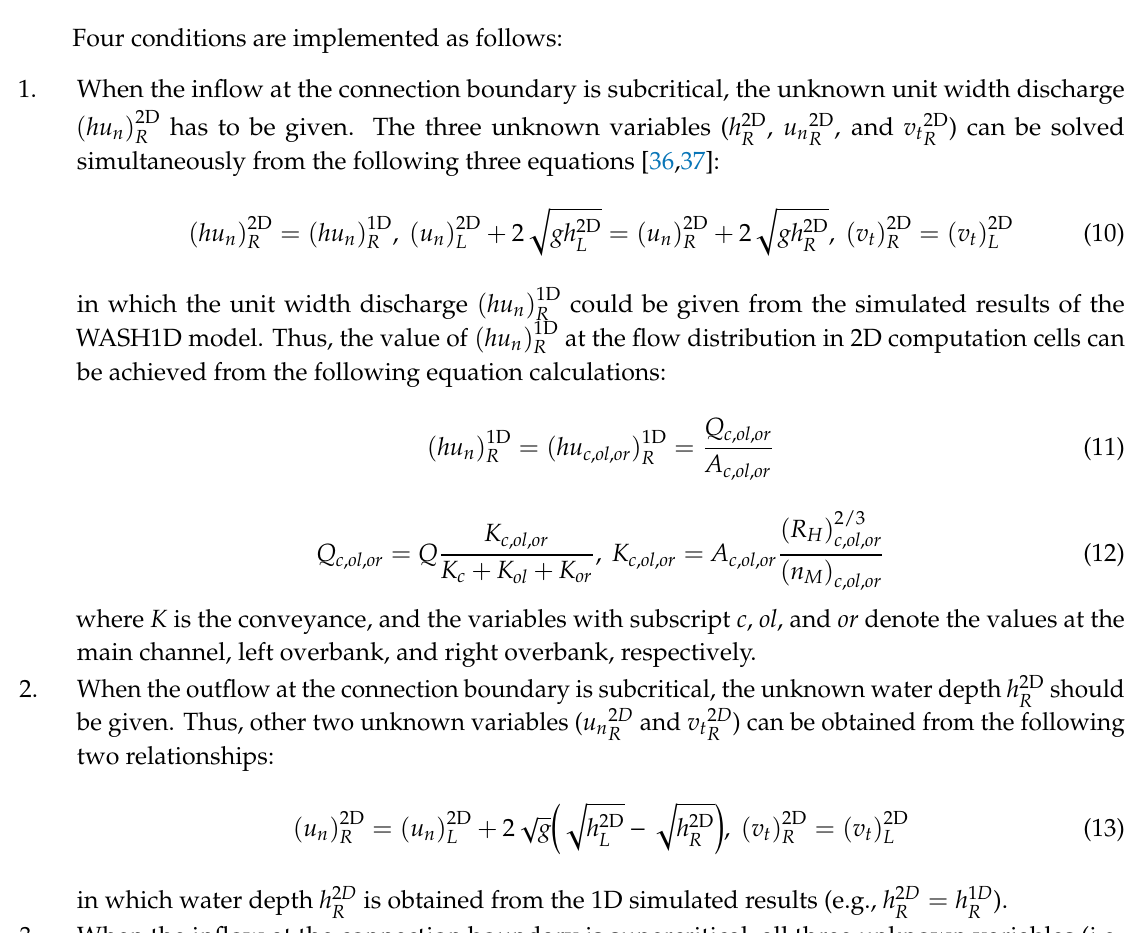
Figure 1. Framework of 1D-2D model